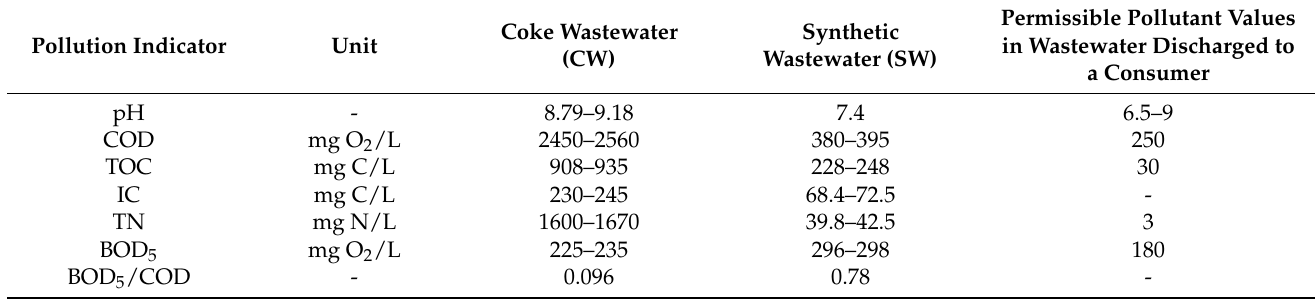
Table 1. Values of individual coke wastewater pollution indicator.